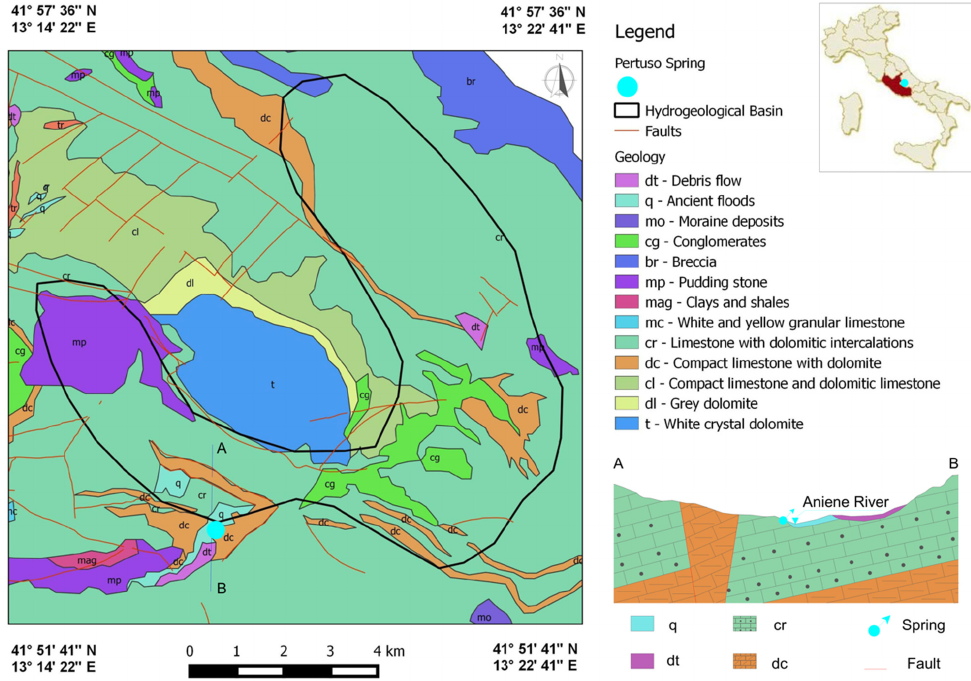
Figure 1. Geological map of the study area and Pertuso Spring hydrogeological basin.